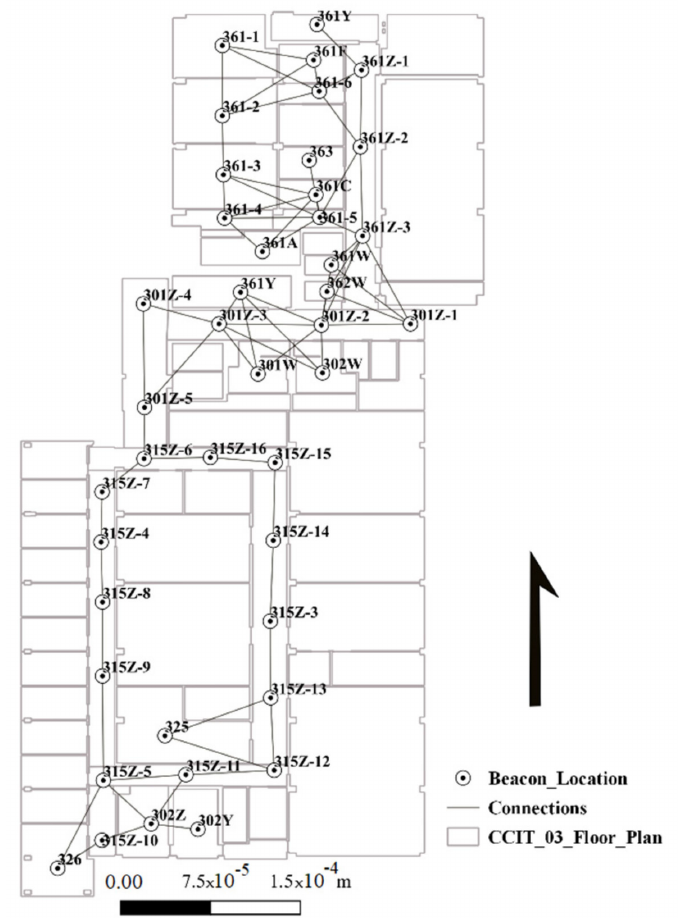
Figure 9. Floor plan of the third floor of Calgary Centre for Innovative Technology (CCIT)